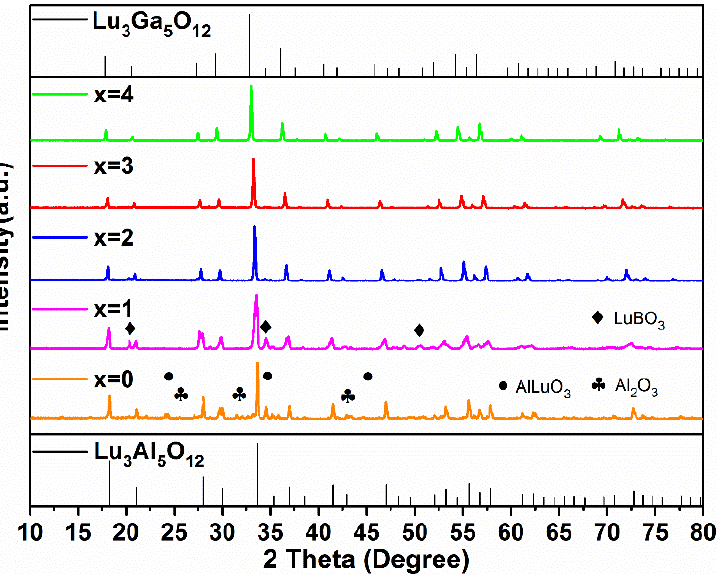
Figure 2. The XRD patterns of the Lu 2 . 94 Ga x Al 5 − x O 12 : 0.06Ce 3+ (x = 0–4) phosphors synthesized at 1350 °C for 3 h.